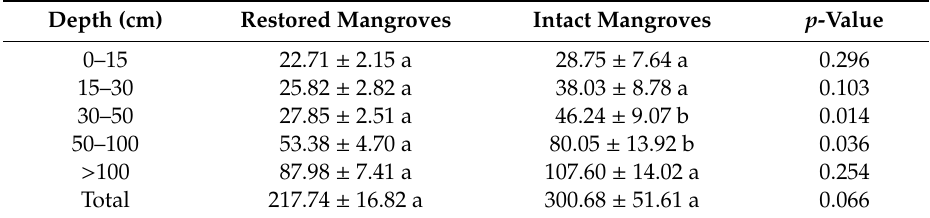
Table 2. Soil carbon pools (mean ± SE) (Mg/ha) according to forest types in the study area. The letters in each row denote the differences between mangrove types.